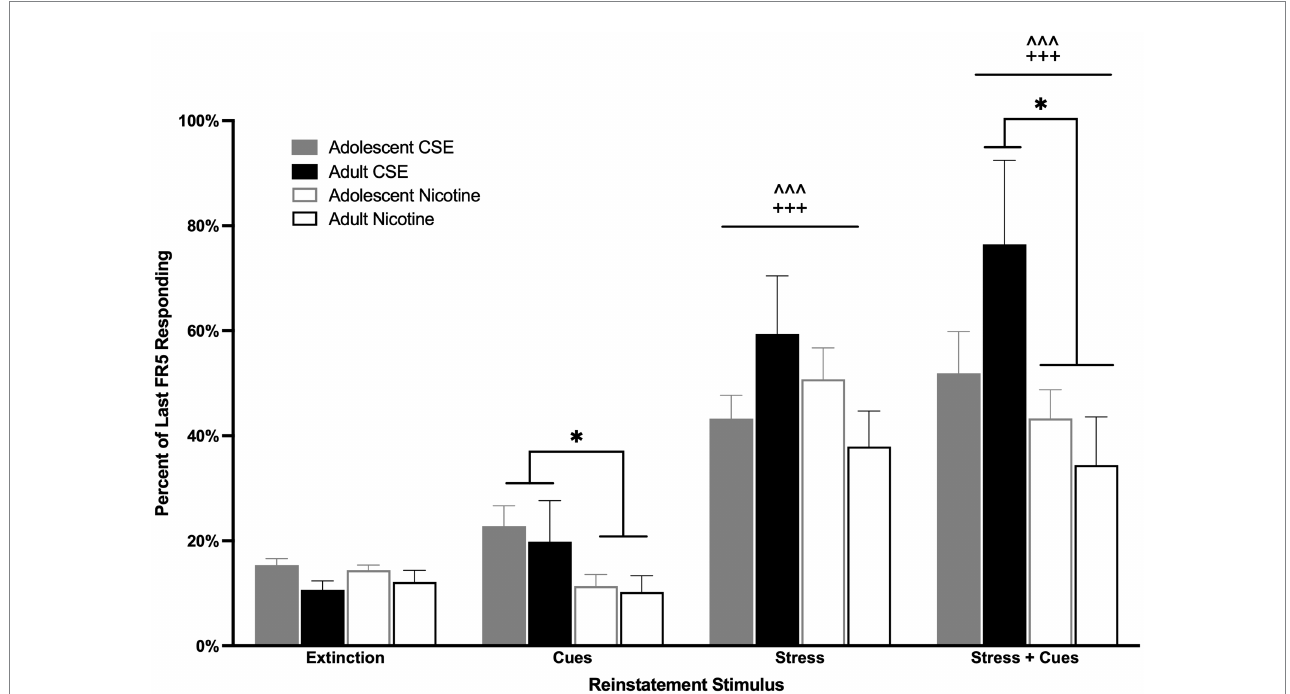
FIGURE 5 Drug differences in cue- and stress + cue-induced reinstatement. The bars represent mean (±SEM) responding on previously reinforced levers, adolescents and adults, that had self-administered CSE (closed bars) or nicotine (open bars). ^^^ p < 0.0001 vs. extinction, +++ p < 0.0001 vs. cue; * p < 0.05 CSE vs. nicotine. n = 12–15 per group.